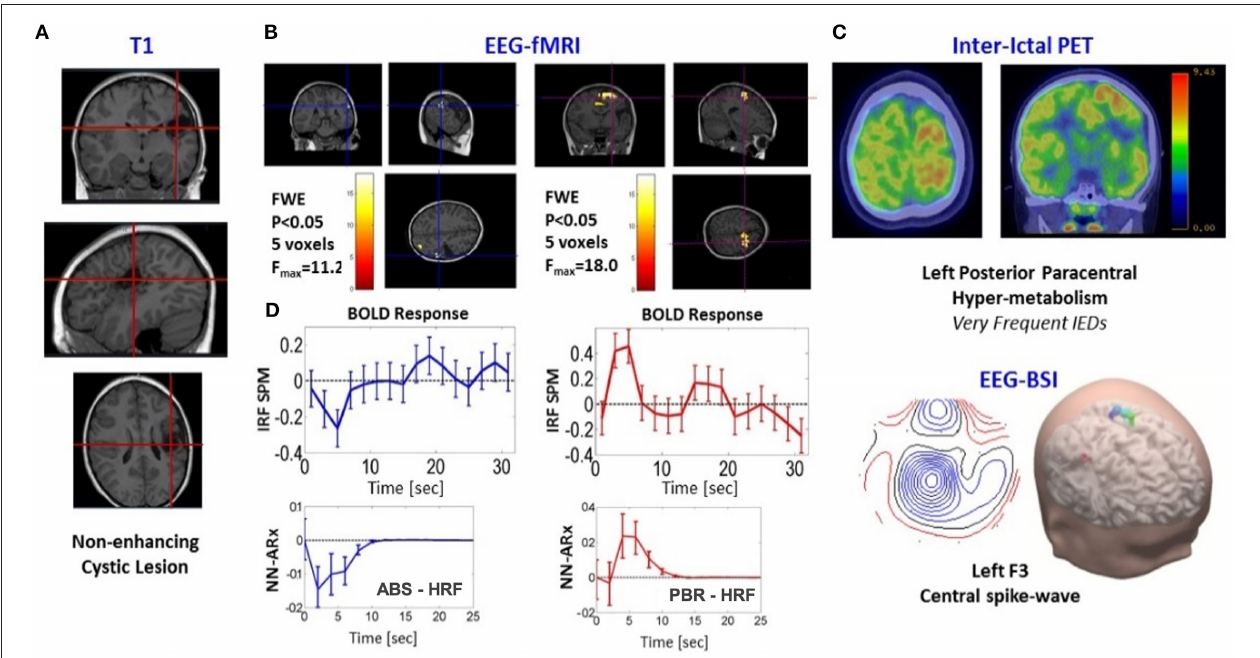
FIGURE 8 | Patients #5 shows an irritative zone with ABS-type HRF. (A) Three different slices of anatomical fMRI imaging (T1-weighted) show non-enhancing cystic lesion in the Left Posterior Frontal Lobe (red crosshairs). (B) Slices showing the thresholded F-statistics map built from the estimated coefficients of the GLM overlaid on the T1-weighted image; left panel, NBR highlighted with blue crosshairs; right panel, PBR highlighted with red crosshairs. (C) Composed panel: top, two slices of nuclear imaging (interictal PET); bottom, EEG-BSI data. (D) Comparison between the NN-ARx method with the impulse response function (IRF) method (SPM software). The IRF method was not able to capture underlying HRFs. Results from the NN-ARx were classified as the ABS